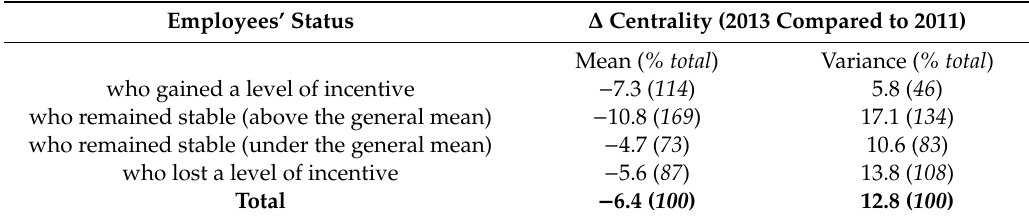
Table 7. The variation of the centrality compared to the change in the levels of